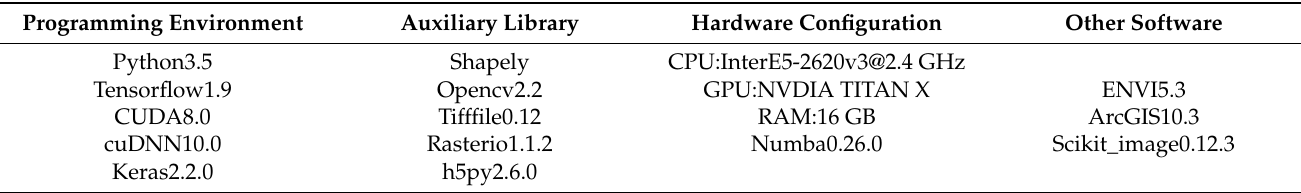
Table 2. Deep learning environment configuration.